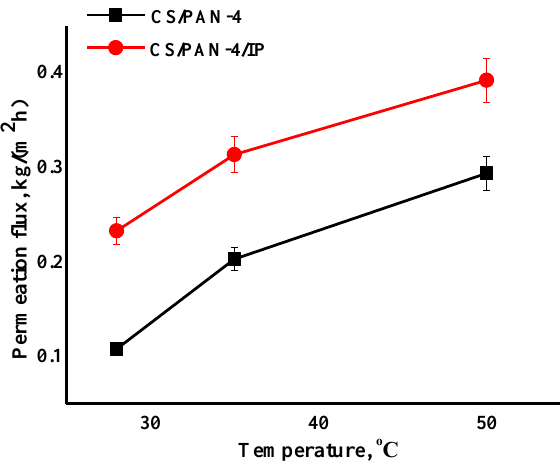
Figure 10. The dependence of the permeation flux on the temperature (28, 35, 50 °C) in pervaporation separation of azeotropic isopropanol / water mixture for the reference CS / PAN-4 and CS / PAN-4 / IP TFC membranes. Water content in the permeate for all membranes was 99.9 wt.%. The mean accuracy for permeation flux was ±6%.